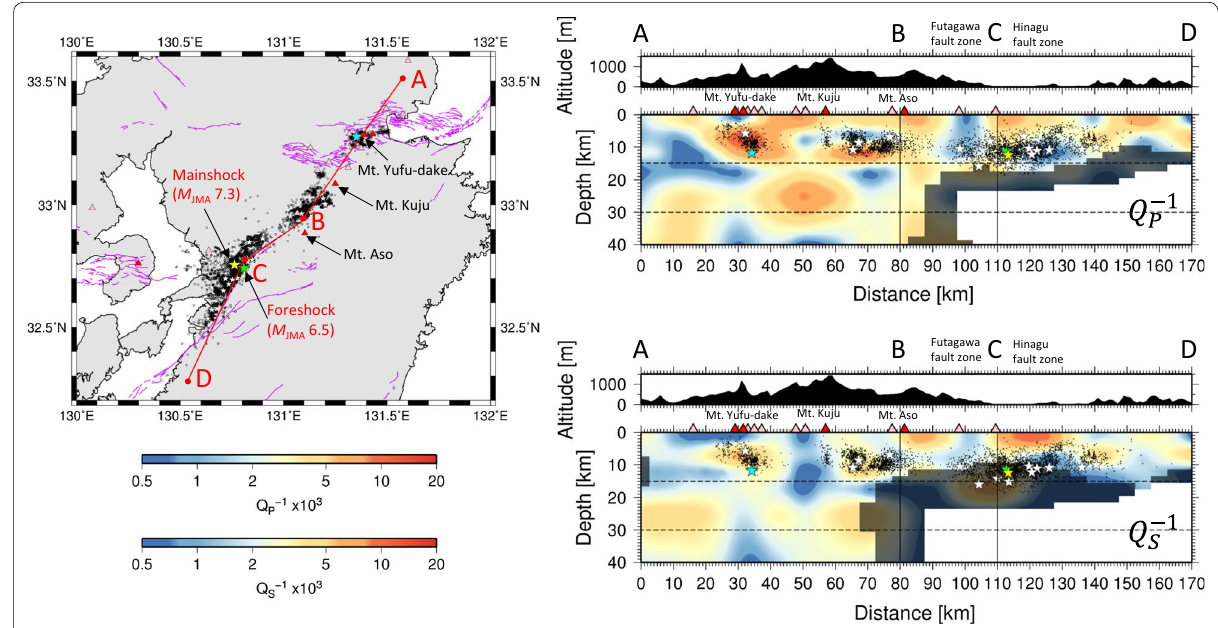
Fig. 3 Vertical cross sections of Q − 1 P and Q − 1 S structures and topography along lines A–B, B–C, and C–D. The region shaded by gray shows low resolu- tion, where the resolvability R of the CRTs is smaller than 0.75. The Conrad and Moho discontinuities in the model are drawn by dashed lines . Green , yellow , and sky blue stars indicate the hypocenters of the largest foreshock ( M JMA 6.5), the mainshock ( M JMA 7.3), and the induced event ( M JMA 5.7), respectively. White stars denote the hypocenters of events larger than M JMA 5.0 for 1 month following the foreshock. Black dots indicate the events with 2.0 M JMA < 5.0 occurring for 1 month following the foreshock. See the caption of Fig. 1 for explanation of the triangle ≤